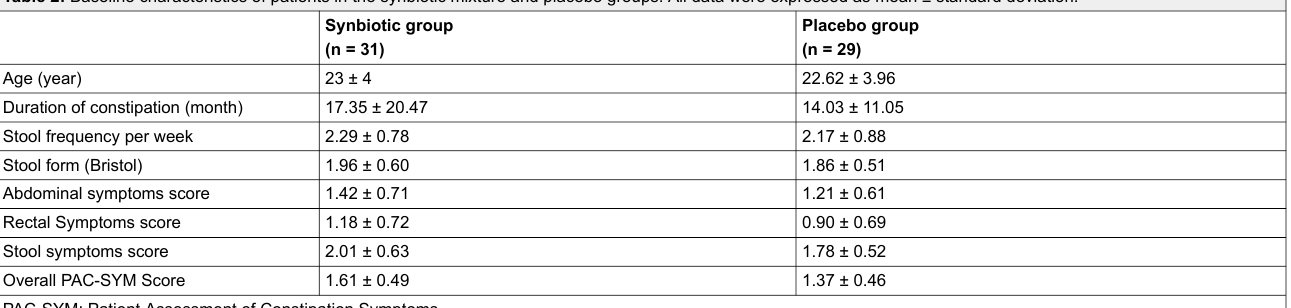
Table 2: Baseline characteristics of patients in the synbiotic mixture and placebo groups. All data were expressed as mean ± standard